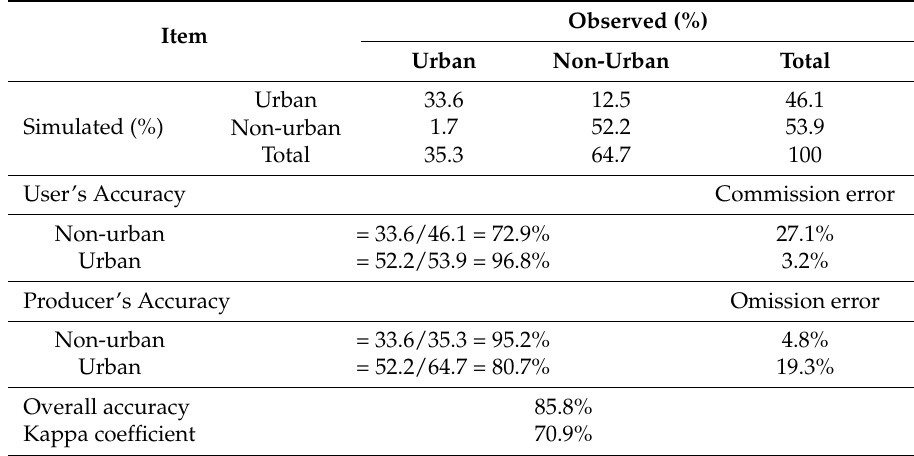
Table 5. Confusion matrix between remote sensing-based classification and simulated urban pattern using the PLS-CA model for Songjiang in